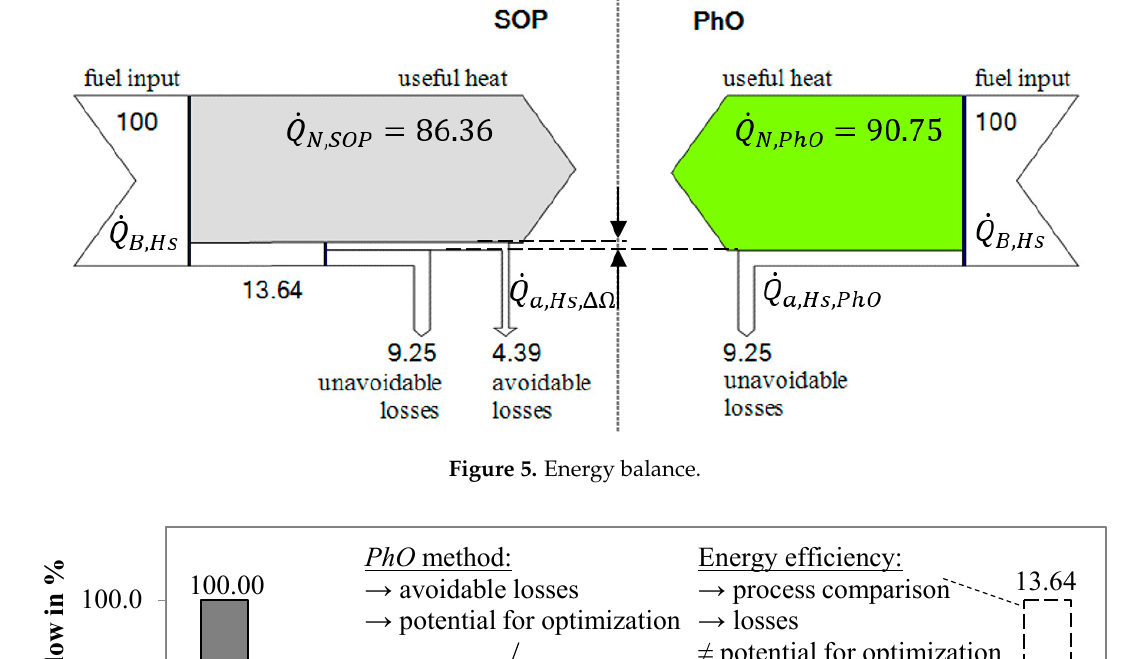
Figure 5. Energy balance.